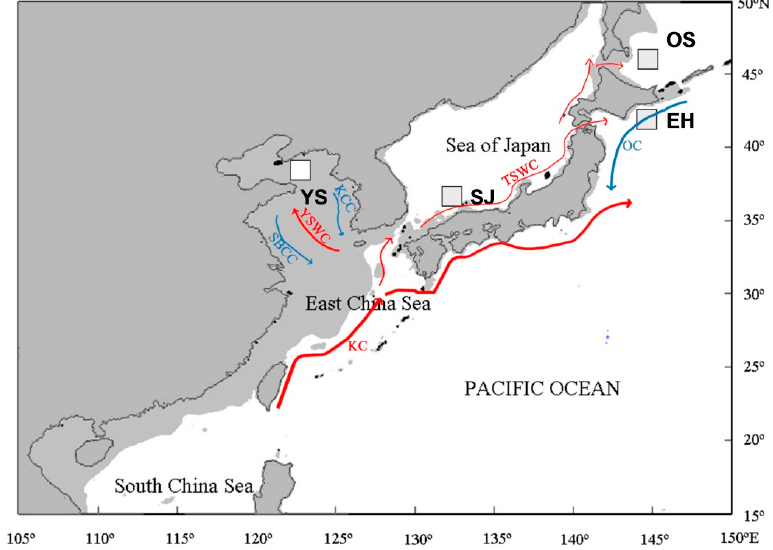
Figure 6. Sampling sites of Pacific cod in the present study. Shaded sea areas are continental shelves that would have been exposed to the air during periods of low sea-level. KC: Kuroshio Current; YSWC: Yellow Sea Warm Current; SBCC: Subei Coastal Current; KCC: Korean Coastal Current; TSWC: Tsushima Warm Current; OC: Oyashio current.